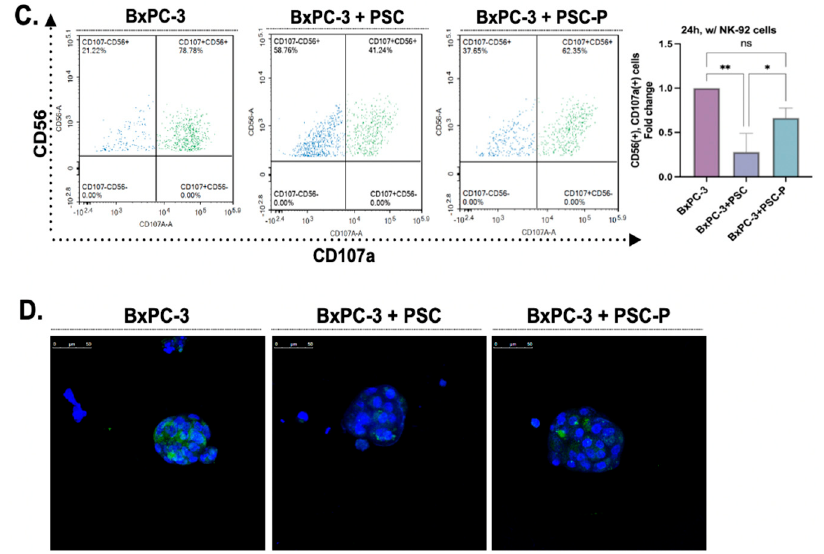
Figure 3. The cytotoxic activity of NK-92 cells increased in the spheroids formed by periostin- suppressed cells. ( A ) Cell-cell interactions in spheroids structures were observed by labeling the cells with CellTracker dyes. BxPC-3 and PSC cells were stained with CellTracker red and green, respectively. Then, the cells were co-cultured in poly-HEMA coated plates for four days to form spheroids. NK-92 cells with CellTracker blue were added to spheroids to observe cell-cell interactions. ( B ) NK-92 cells were treated with two different concentrations of lenalidomide (1 and 10 µ M) for 24 and 48 h. NT group left untreated. Then the cells were cultured with BxPC-3 cells for 24 h to evaluate their cytotoxic activity. CD56 antibody was used to distinguish NK-92 cells from BxPC-3 cells. Then, CD107a + cells were analyzed in the CD56 + population to assess the cytotoxic activity of NK-92 cells. Lena; lenalidomide. ( C ) BxPC-3 mono-culture, BxPC-3+PSC, and BxPC-3+PSC-P co-culture spheroids were exposed to NK-92 cells pre-treated with 1 µ M lenalidomide for 24 h. Following 24 h exposure, the percentage of CD107a + cells was analyzed in the CD56 + population. ( D ) Confocal images of spheroids cultured with lenalidomide-treated NK-92 cells for 24 h. Green shows the infiltration of CD107a + NK-92 cells, and blue shows DAPI staining for nuclei. * p < 0.05, ** p <